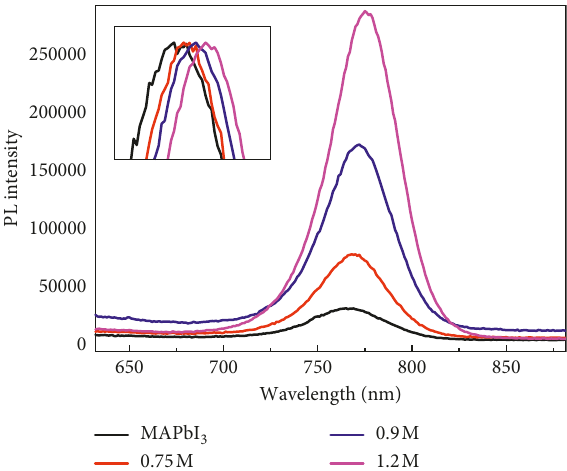
Figure 5: PL spectra of perovskite films with Sample+0M, Sample+0.75M, Sample+0.9M, and